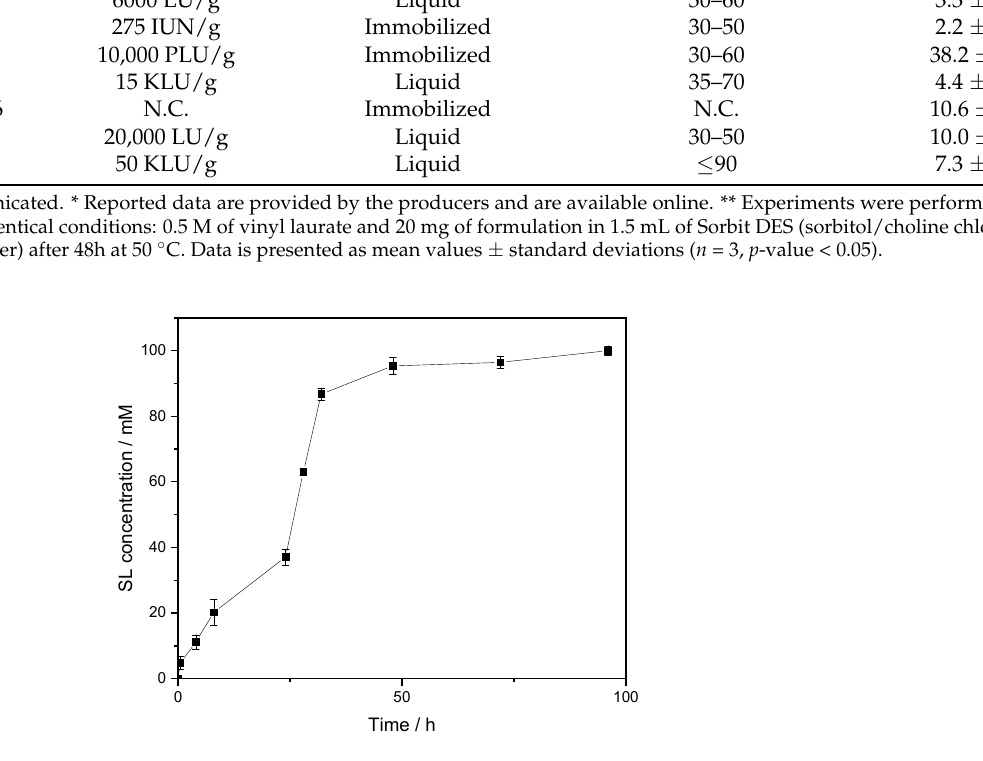
Figure 3. Time course of the reaction under unoptimized conditions: 0.5 M of vinyl laurate, 20 mg of Novozym 435 ® and 1.5 mL of Sorbit DES as solvent (sorbitol/choline chloride, 1:1, mR, 5 wt.% water) at 50 °C.